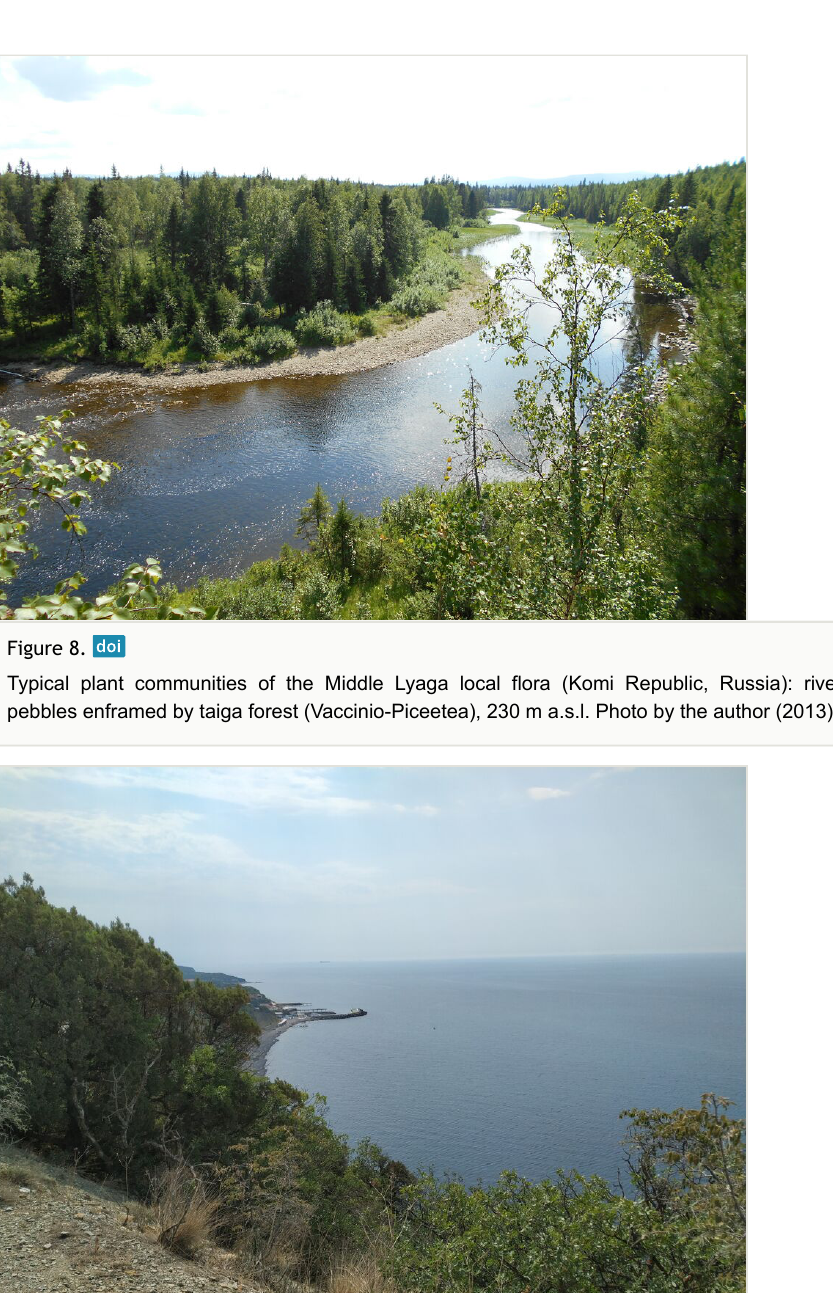
Figure 9. Typical plant communities of the Utrish local flora (Krasnodar Krai, Russia): xeric stands of Juniperus excelsa M.Bieb. along the Black Sea Coast. Photo by the author